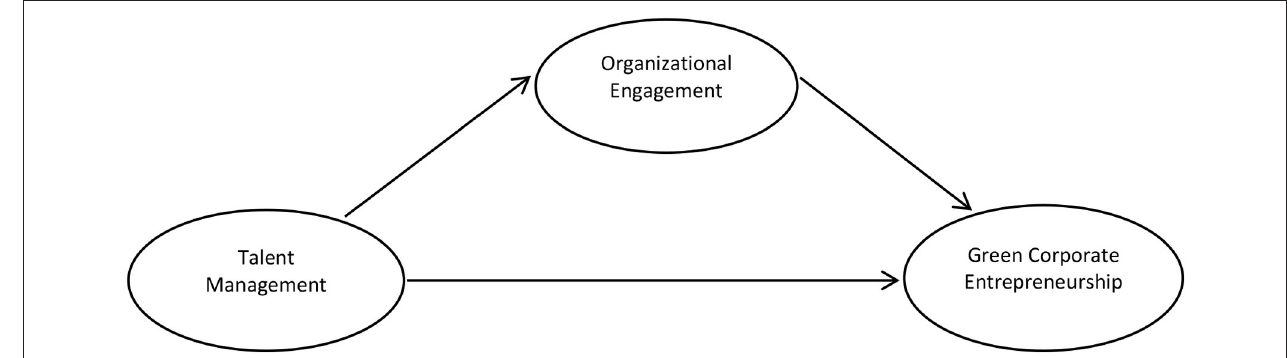
FIGURE 1 | Conceptual framework of the study.